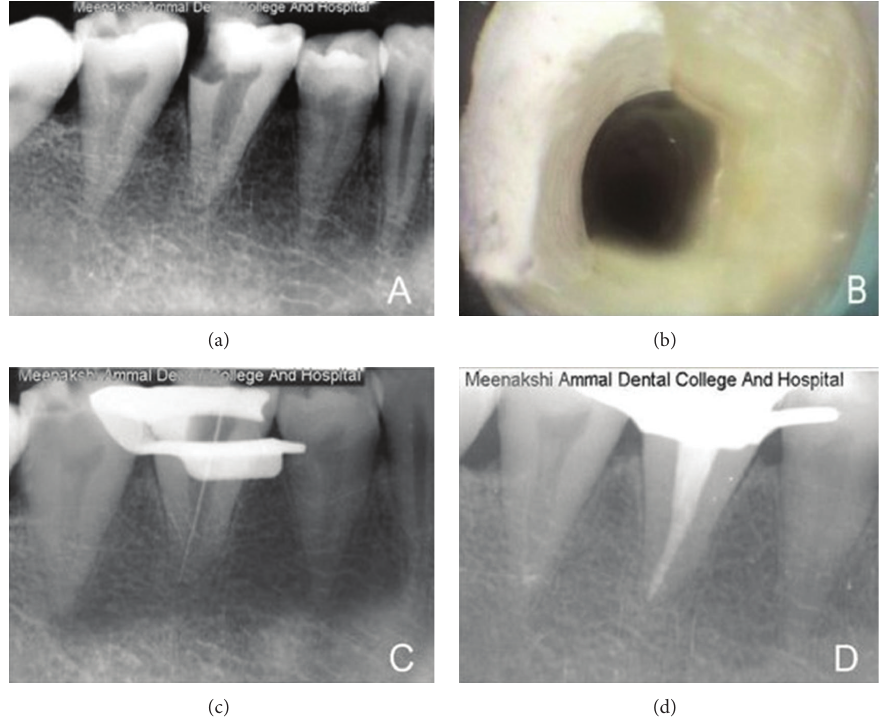
Figure 1: (a) Preoperative radiograph showing the posterior teeth with single root. (b) Access opening demonstrating single canal. (c) Working length radiograph. (d) Postobturation